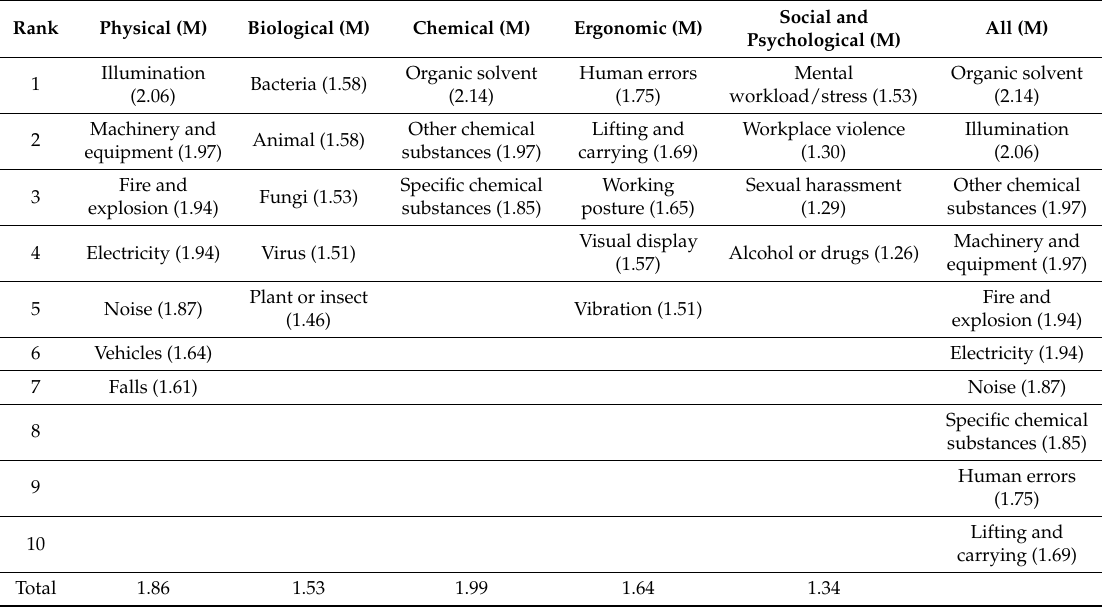
Table 2. Ranks of hazard management